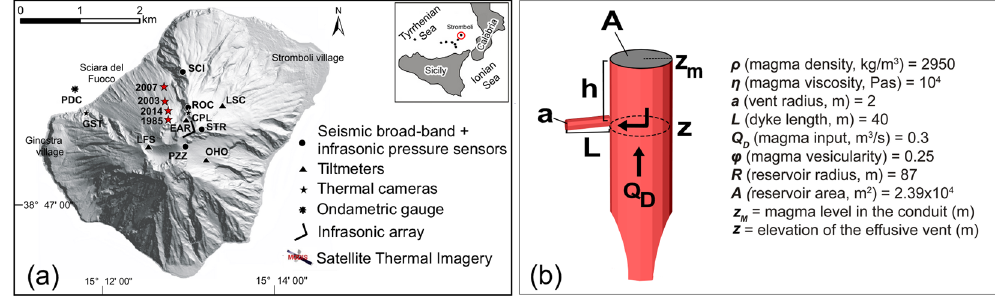
Figure 1. ( a ) Shaded relief map of Stromboli showing the permanent geophysical network deployed by the Laboratorio di Geofisica Sperimentale (University of Florence) since 2003. The red stars indicate the positions of the effusive vents during the four eruptions that occurred in 1985, 2003, 2007 and 2014 along the flank of Sciara del Fuoco. The map of Stromboli was created using Matlab ver. 7.5.0.338 (R2007b). ( b ) A sketch of the shallow reservoir with the main parameters used to define the geometry of the feeding system considered in the